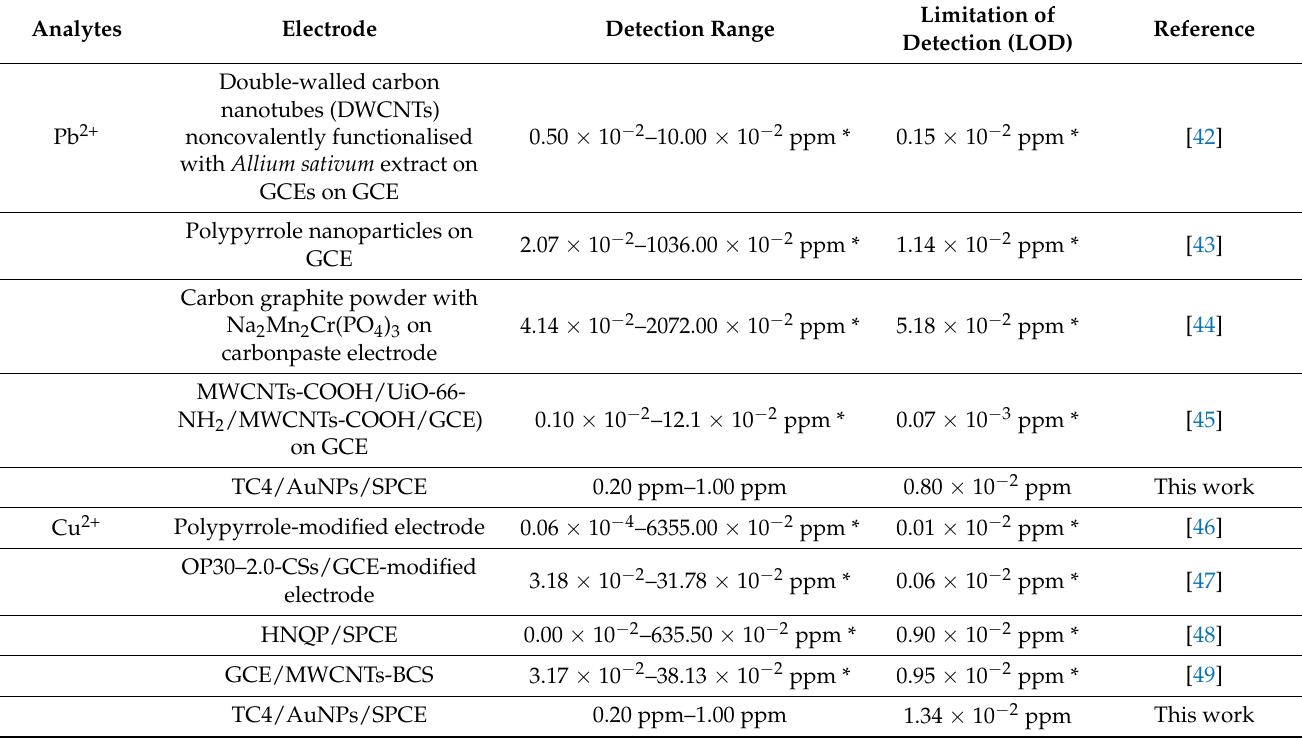
Table 1. Comparison of the performance of recently developed sensors and the proposed sensor toward Pb 2+ and Cu 2+ .